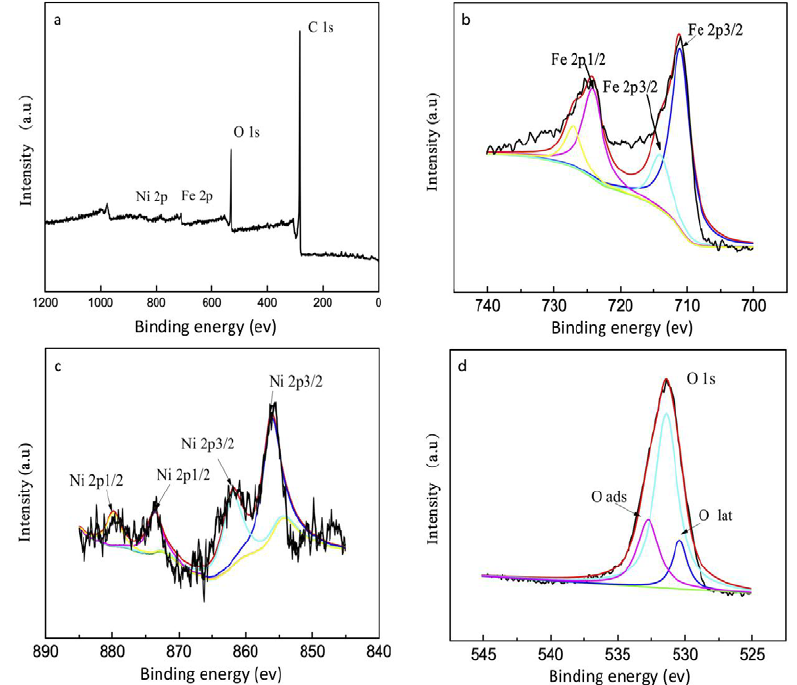
Figure 4. X-ray photoelectron spectroscopy (XPS) spectra of full scale ( a ), Fe 2p ( b ), Ni 2p ( c ) and O 1s ( d ) for the Fe-Ni/MAC catalyst. ( d ) for the Fe-Ni / MAC